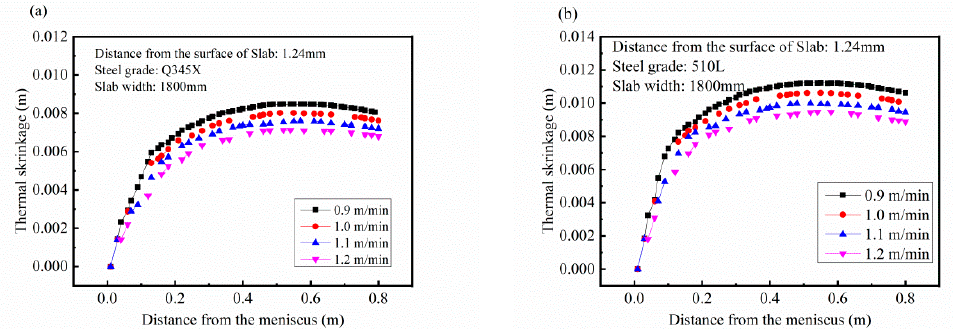
Figure 6. Thermal shrinkage for di ff erent speeds. ( a ) Q345X; ( b ) 510L.